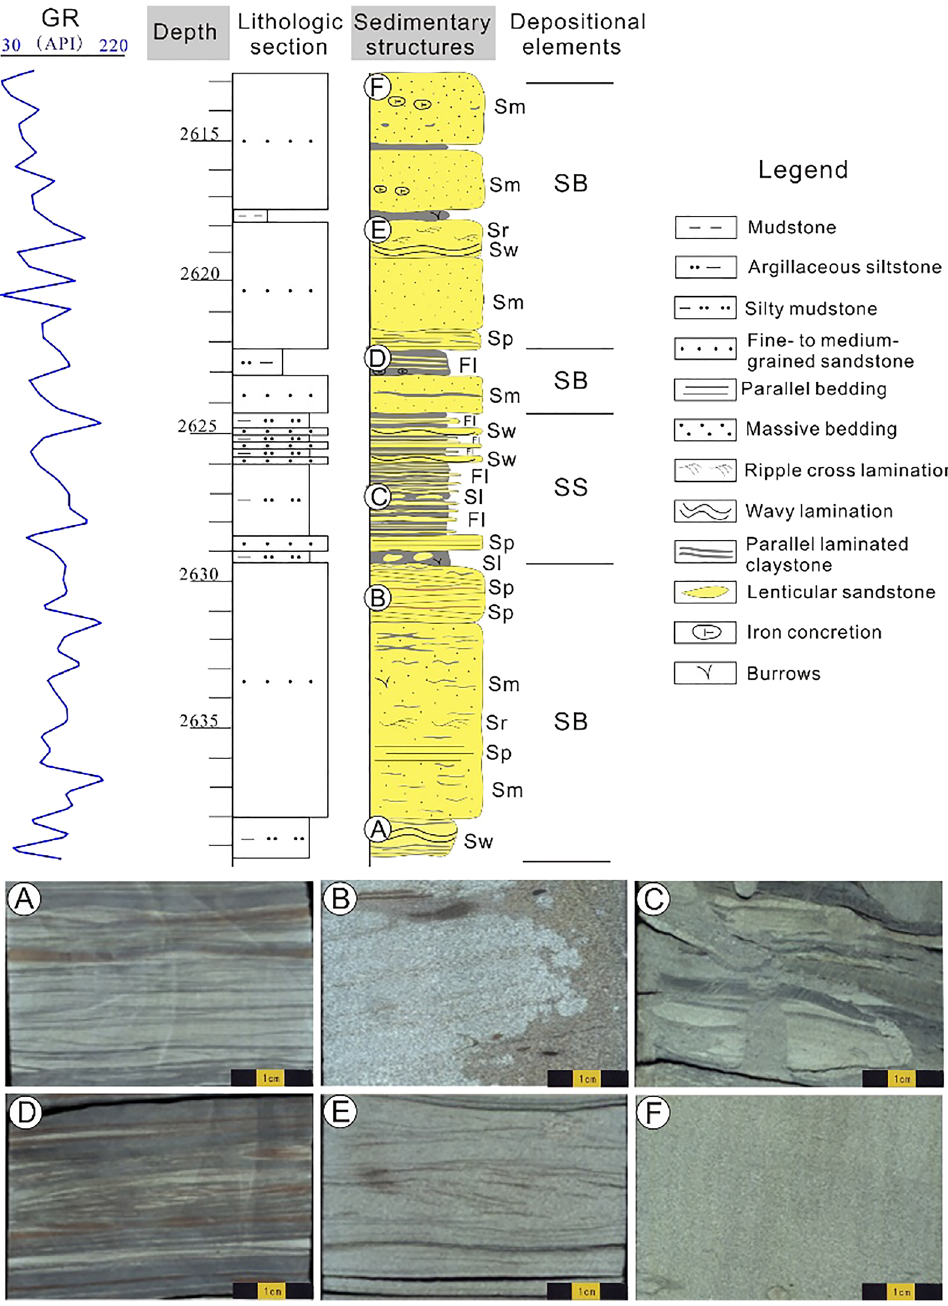
Figure 5. Single well section description of well H2. Various sedimentary structures indicate complicated hydrodynamic environment. Sm, SP, Sr, Sl, Sw and Fl represent 6 different lithofacies. SB and SS represent 2 different depositional systems. See detailed information of these acronyms in the